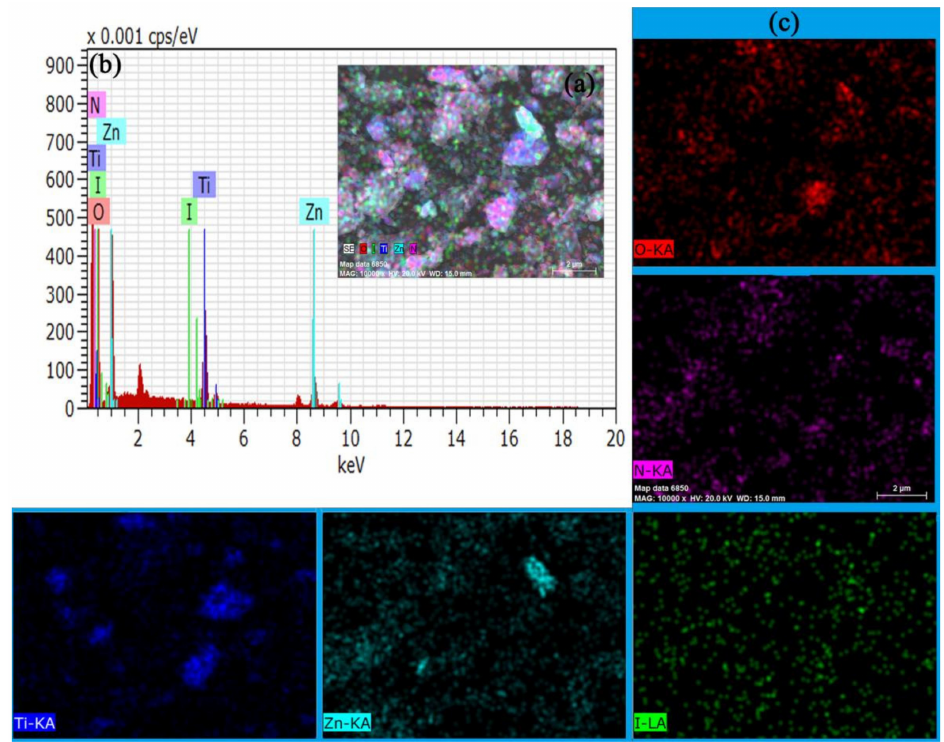
Figure 3. ( a , b ) ZIF-8@TiO 2 (5%KI) EDX diagram, ( c ) single element EDX diagram of ZIF-8@TiO 2